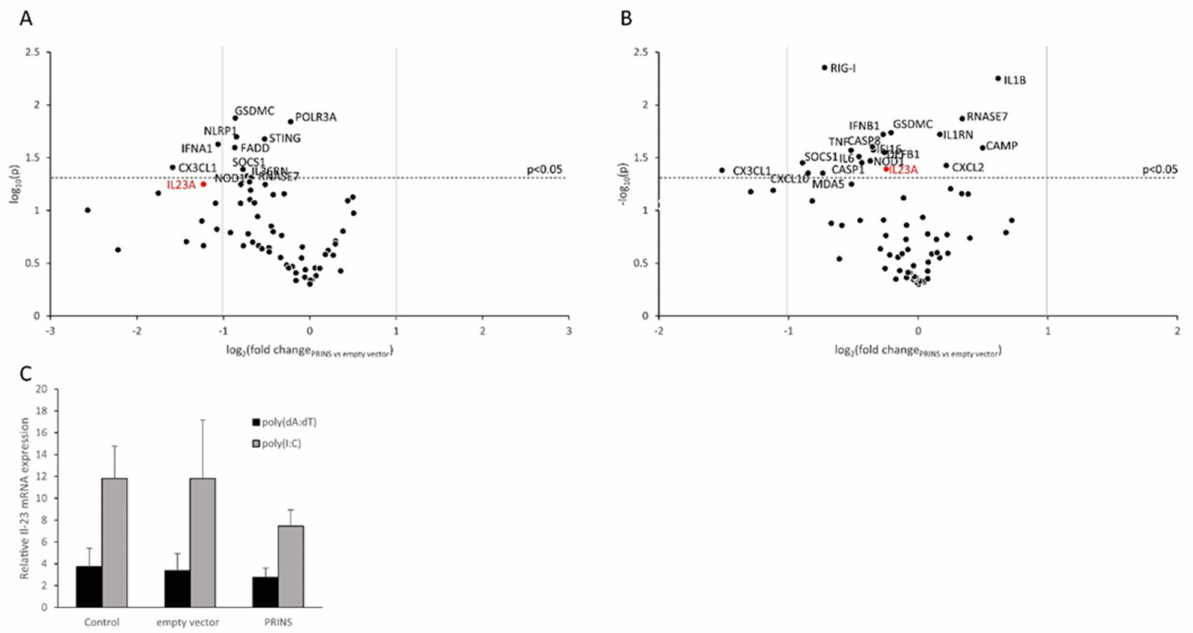
Figure 6. Gene expression changes upon the overexpression of the PRINS long non-coding RNA in NHEKs transfected with poly(I:C) ( A ) and poly(dA:dT) ( B ). RT-PCR validation of the array results regarding nucleic-acid-induced IL-23 mRNA expression upon PRINS overexpression in NHEKs ( C ). To assess multiple gene expression changes, a qPCR array of inflammatory mediators and receptors was carried out on NHEK cells transfected by a pcDNA3.1(+) vector containing the PRINS sequence or the empty verctor. Subsequently, 24 h later, PRINS or emtpy-vector-carrying cells were transfected by 0.666 µ g/mL poly(I:C) ( A ) or 1 µ g/mL poly(dA:dT) ( B ) for 12 h. Expression changes in PRINS-overexpressing samples were compared to expression values of empty-vector- transfected samples. Results are presented as volcano plots, significant changes ( p < 0.05) are displayed above the horizontal dashed line. Vertical lines indicate a ± 2-fold change in expression compared to empty-vector-transfected cells. Experiments were carried out on four independent samples derived from healthy voluteers, statistical significance was calculated by Student’s t -test with correction for multiple comparisons (A and B). Cells overexpressing PRINS were transfected with 0.666 µ g/mL poly(I:C) and 1 µ g/mL poly(dA:dT). Relative IL-23 mRNA expression was determined by the ∆∆ Ct method, normalized to GAPDH mRNA expression and compared to the expression of the untreated (Control) samples. For the RT-PCR experiment, we used the same total mRNA sample set ( n = 4) as for the array experiment. Data are presented as mean of four independent experiments ± SD. Statistical significance was not found as assesed by one-tailed, paired Student’s t -test ( C